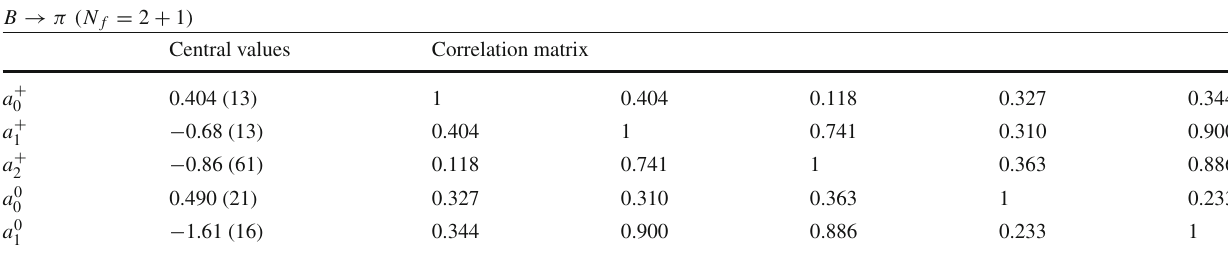
Table 46 Coefficients and correlation matrix for the N + = N 0 = 3 z -expansion fit of the B → π form factors f + and f 0 . The coefficient a 0 fixed by the f + ( q 2 = 0 ) = f 0 ( q 2 = 0 ) constraint. The chi-square per degree of freedom is χ 2 / dof = 0 . 82. The lattice calculations that enter this fit are taken from FNAL/MILC 15 [556] and RBC/UKQCD 15 [557]. The parameterizations are defined in Eqs. (532) and (533) B → π ( N f = 2 + 1